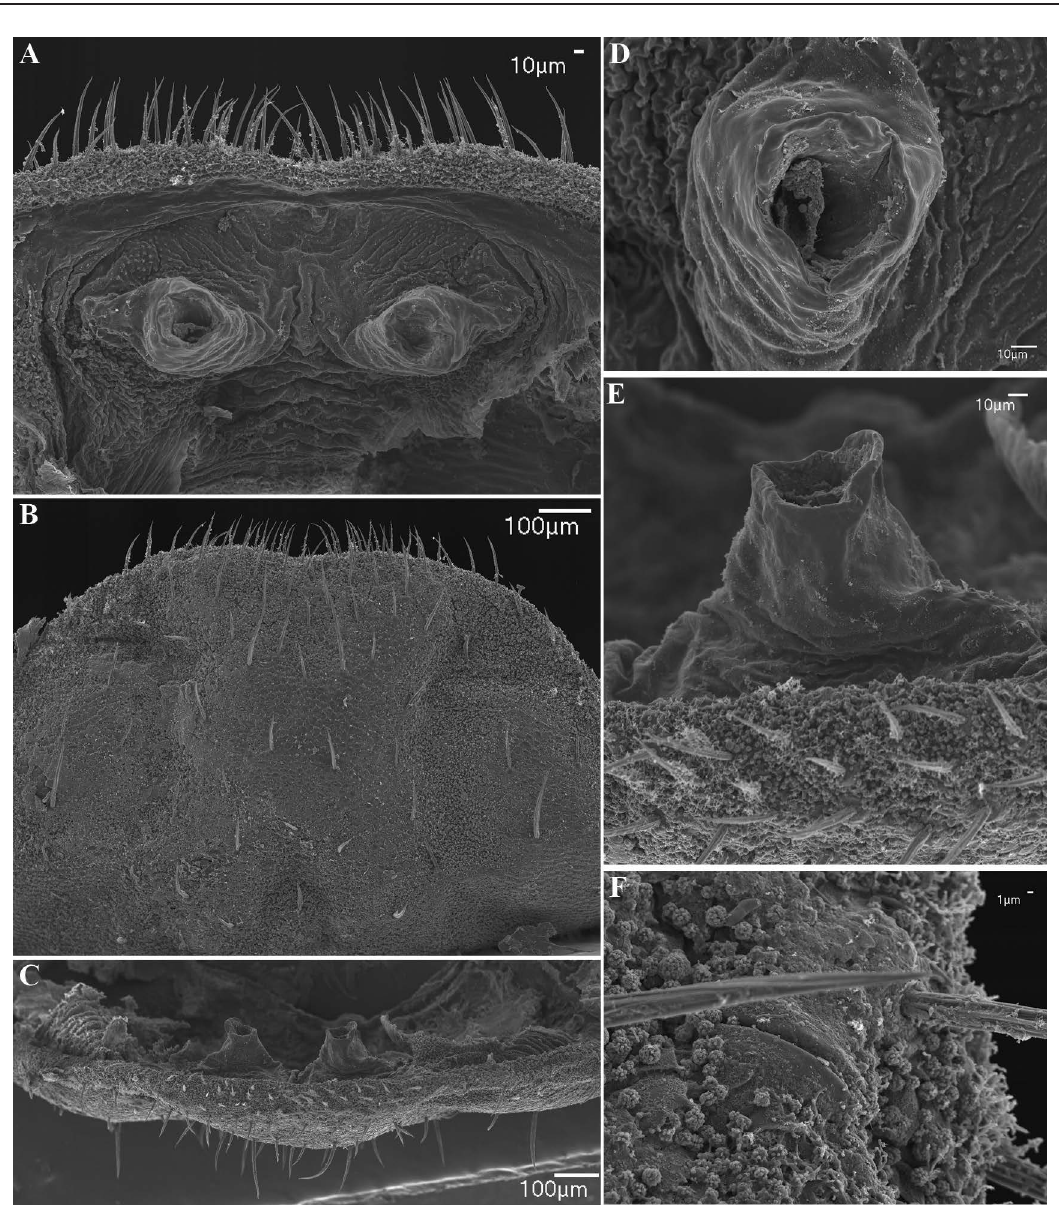
Fig. 45. Charinus alagoanus sp. nov. (MNRJ 9295), female gonopod and genital operculum. A . Sucker- like gonopod, dorsal view. B . Genital operculum, ventral view. C . Gonopods, posterior view. D . Aperture on sinistral side of sucker-like gonopod, dorsal view. E . Projection on sinistral side of sucker-like gonopod, posterior view. F . Gland opening near lateral margin of